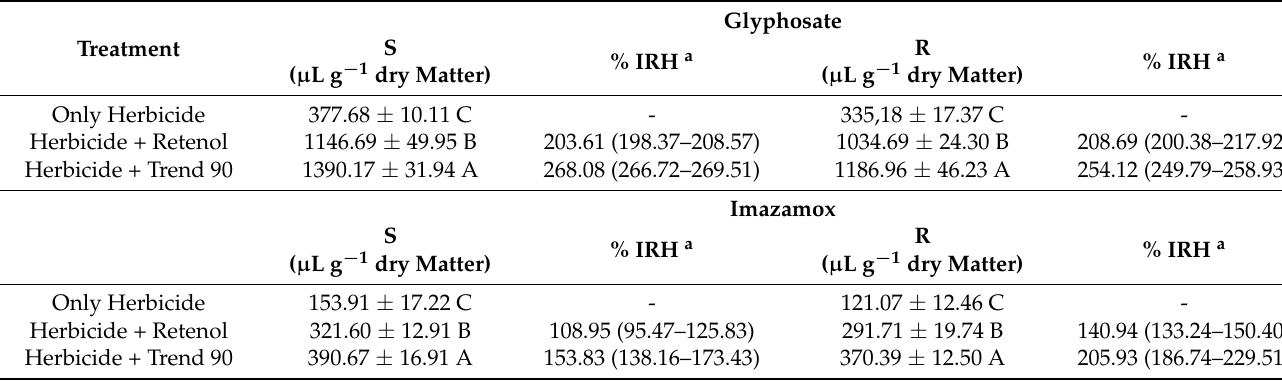
Table 5. Foliar retention (expressed as g − 1 dry matter) of glyphosate (360 g ae ha − 1 ) and imazamox (40 g ai ha − 1 ) with and without adjuvants and increased retained herbicide in R and S populations of Chloris radiata.